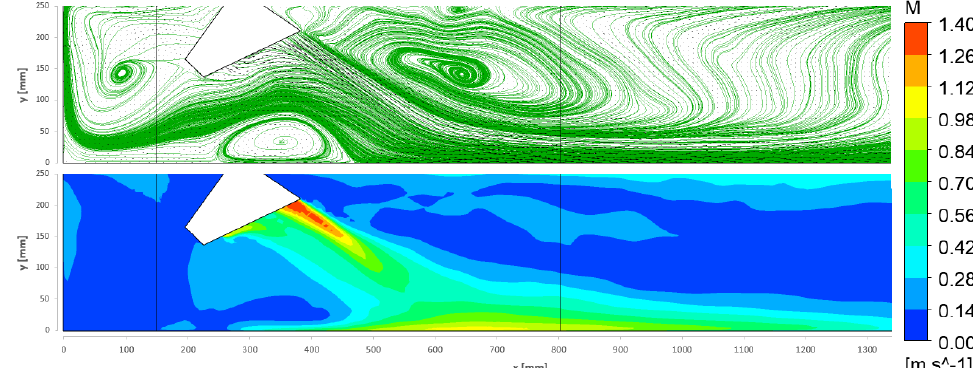
Figure 13. Finite volume method (SAS model), vector lines ( top ) and the magnitude of time-averaged 2D velocity ( bottom ) in vertical plane ( z = 75mm )